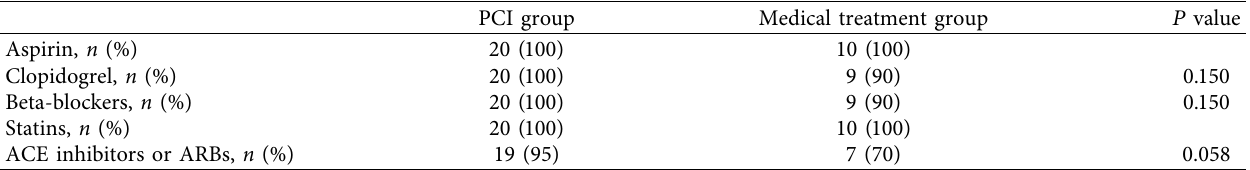
Table 3: Medication logs at discharge.